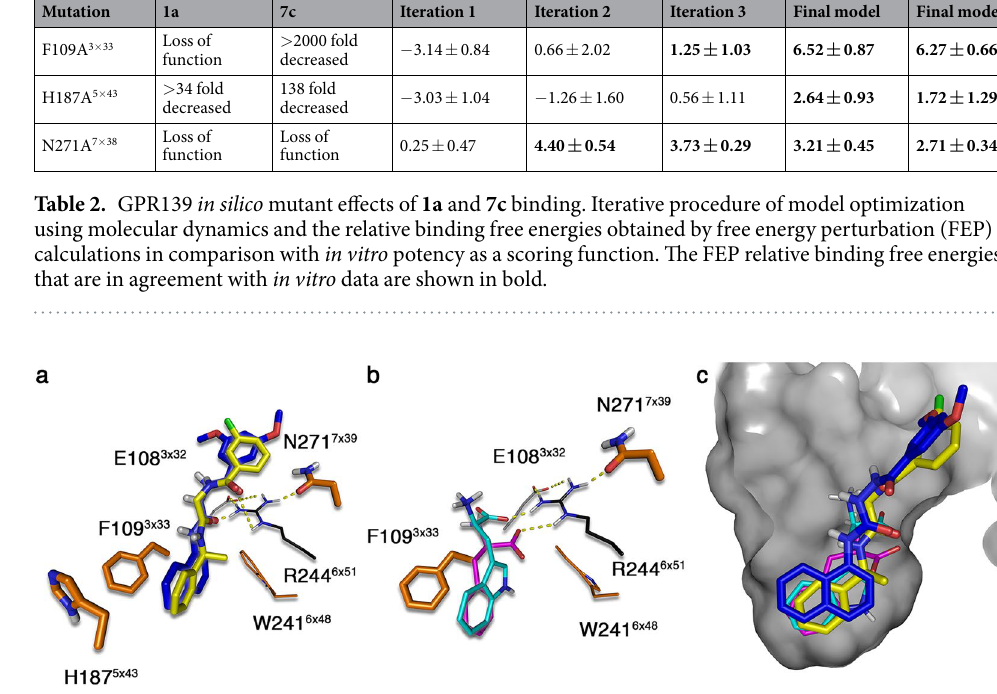
Figure 4. 1a , 7c , l- Trp , and l -Phe binding pose models. ( a ) Binding mode of 1a (blue) and 7c (yellow) and ( b ) endogenous amino acids l- Trp (cyan) and l -Phe (magenta). Mutations that showed a significant effect when mutated are colored orange. Residues with thick sticks have been mutated in silico and in vitro (F109 3 × 33 , H187 5 × 43 and N271 7 × 39 ) and those with thin sticks in vitro only (W241 6 × 48 ). The latter was excluded due to the dynamic role of this residue as an activation switch in class A GPCRs 25 . Residues colored in grey showed no significant changes in potency (E108 3 × 32 ) and those in black were not expressed respectively (R244 6 × 51 ). ( c ) Overlay of all four studies ligands within the GPR139 binding pocket shown as a surface. All tested agonists bind a deep hydrophobic pocket and are shown to undergo hydrogen bonding with R244 6 × 51 The 7c binding site. In vitro mutation effects on ligand potencies . All mutants that had an effect on 1a also affected 7c potency, although F109L 3 × 33 and H187A 5 × 43 displayed a milder (yet ~100-fold) effect (Table 1). In silico mutation effects on calculated binding affinities. Compound 7c was docked in the optimized structure of GPR139 obtained from iteration 3 of the GPR139- 1a complex, resulting in similar poses for the two ligands.